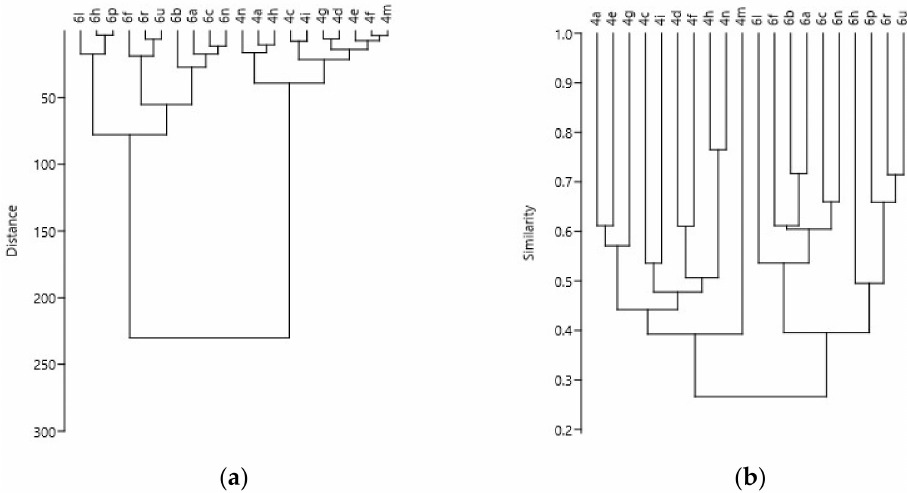
Figure 6. ( a ) Cluster Analysis graphic applied to the 20 structural surveys (the abbreviations in the branches correspond to the numbers of the plots); ( b ) cluster analysis graphic applied to the 20 phy- tosociological relev é s (the abbreviations in the branches correspond to the numbers of the plots). Ground measurements of the diameter of cork tree trunks and burnt pine logs on the ground turned out to be quite similar to those from the UAV. In fact, in any case, there was an average measurement discrepancy never exceeding one cm (Table